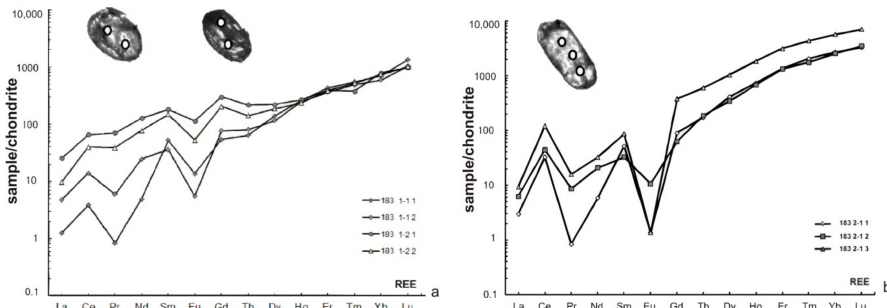
Figure 5. REE pattern in zircons from metagabbro of the Kandalaksha massif (sample 183), normalized after [33]. ( a ) Samples 183 1-1 and 183 1-2; ( b ) Sample 183